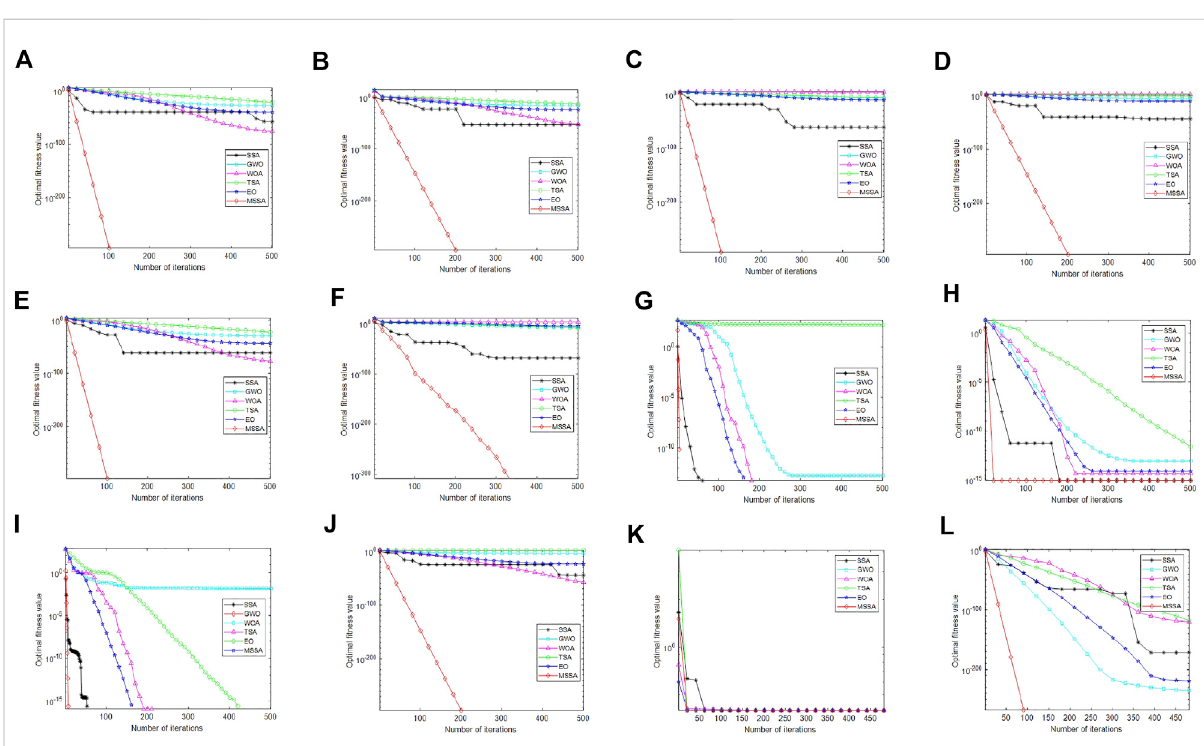
FIGURE 6 Comparison of optimization of each algorithm. (A) f1 mean convergence curve. (B) f2 mean convergence curve. (C) f3 mean convergence curve. (D) f4meanconvergencecurve. (E) f5meanconvergencecurve. (F) f6meanconvergencecurve. (G) f8meanconvergencecurve. (H)